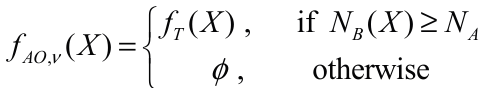
Figure 5. Comparision of the obtained binary images: ( a ) original gray-scale minage; ( b ) the smoothed image; ( c ) obtained binary image from ( a ); ( d ) obtained binary image from ( b ).